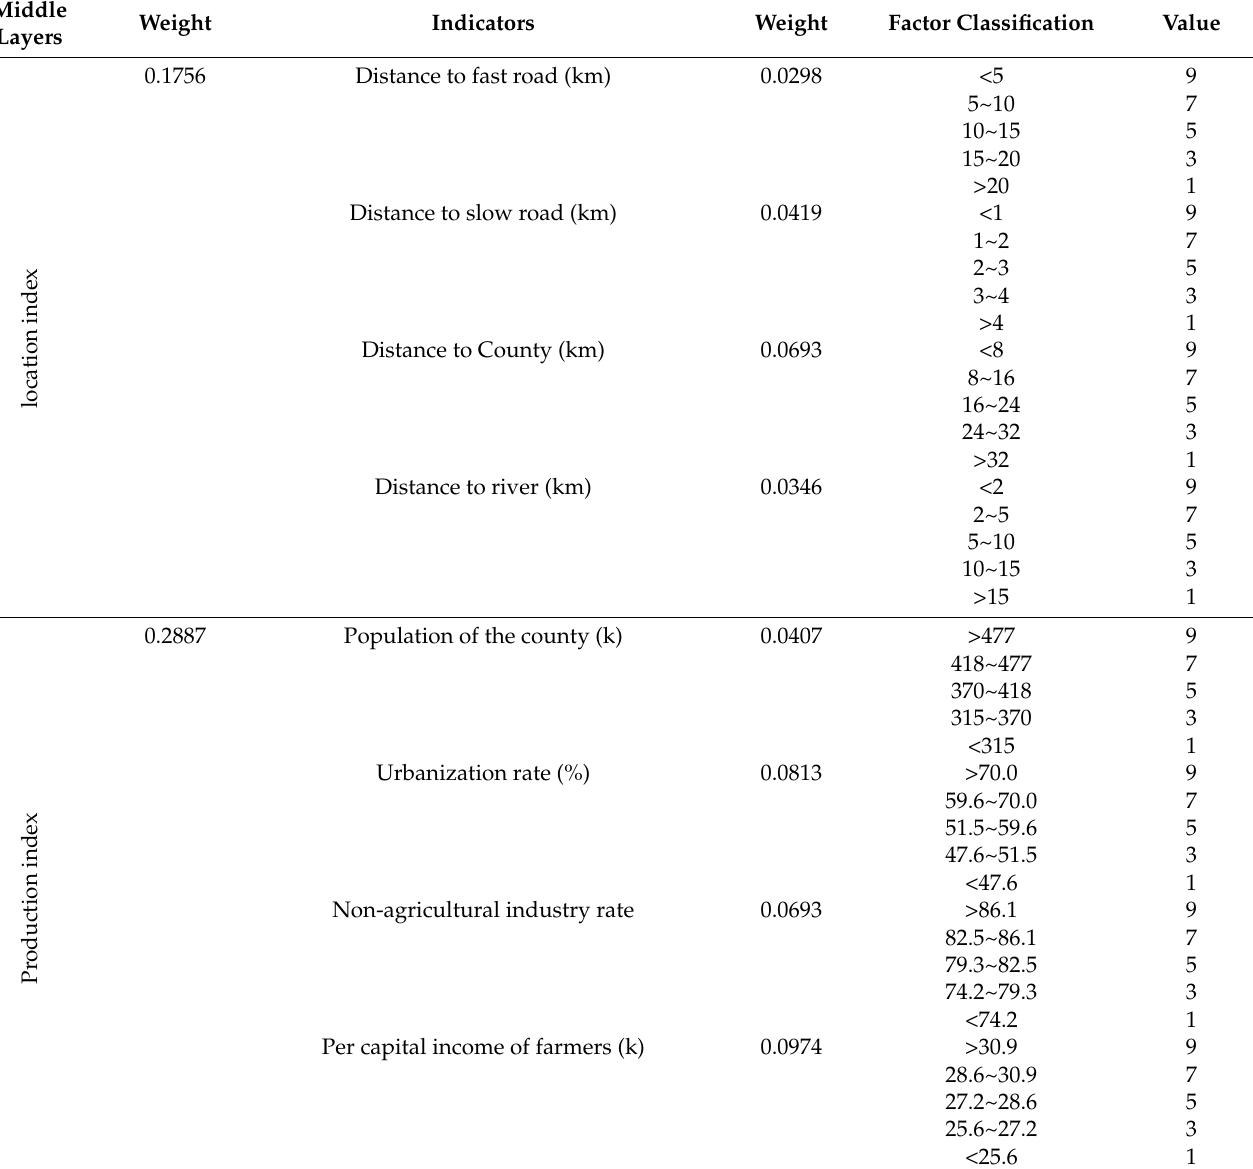
Table 2. Table of suitability evaluation indicators.